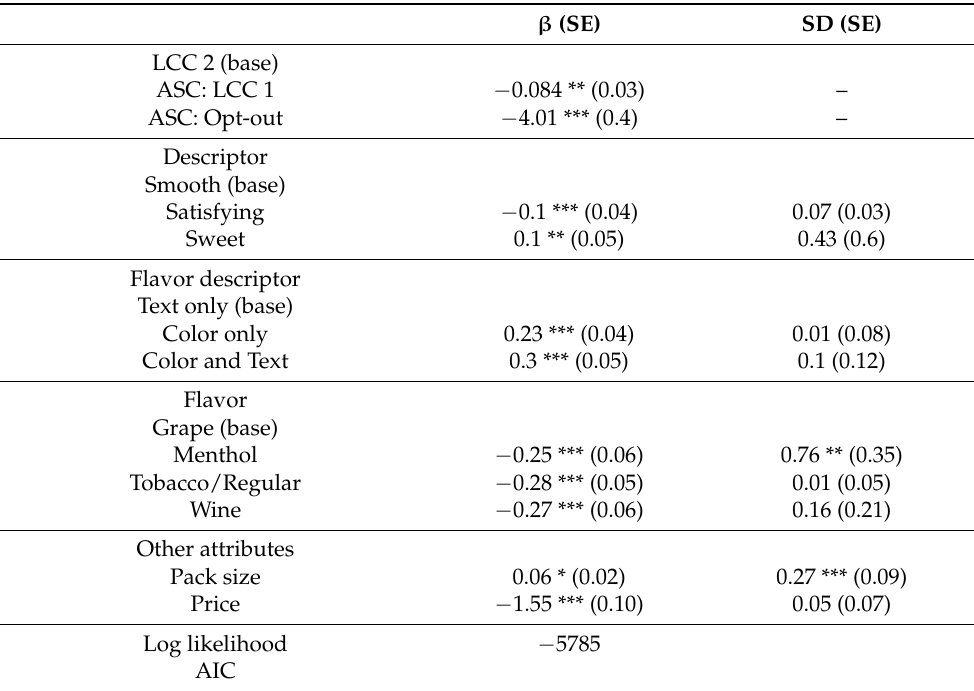
Table 2. The impacts of cigarillo package attributes on cigarillo choices using random parameter logit